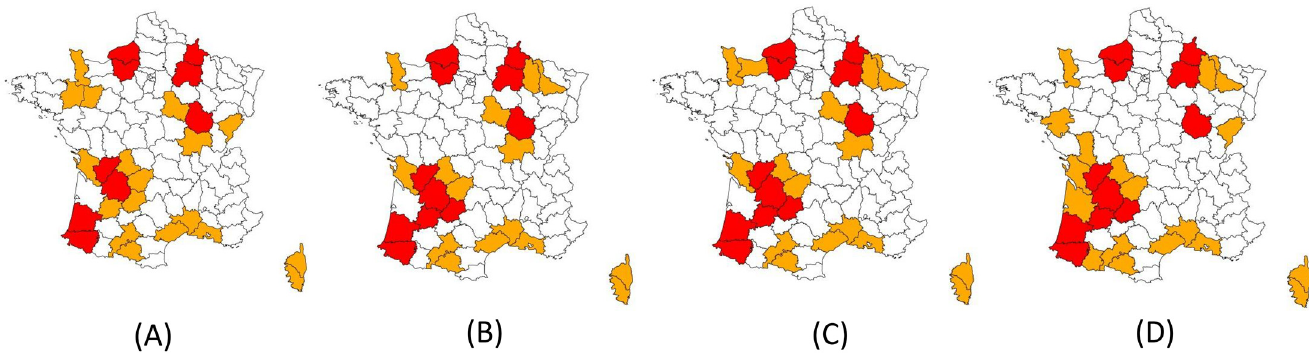
Fig 1. Geographical risk levels for the surveillance of bTB in wildlife in France from 2013 to 2015. Low-risk level: white, Medium-risk level: orange; High-risk level: red. From left to right: (A) July 2013, (B) January 2014, (C) July 2014 and (D) January